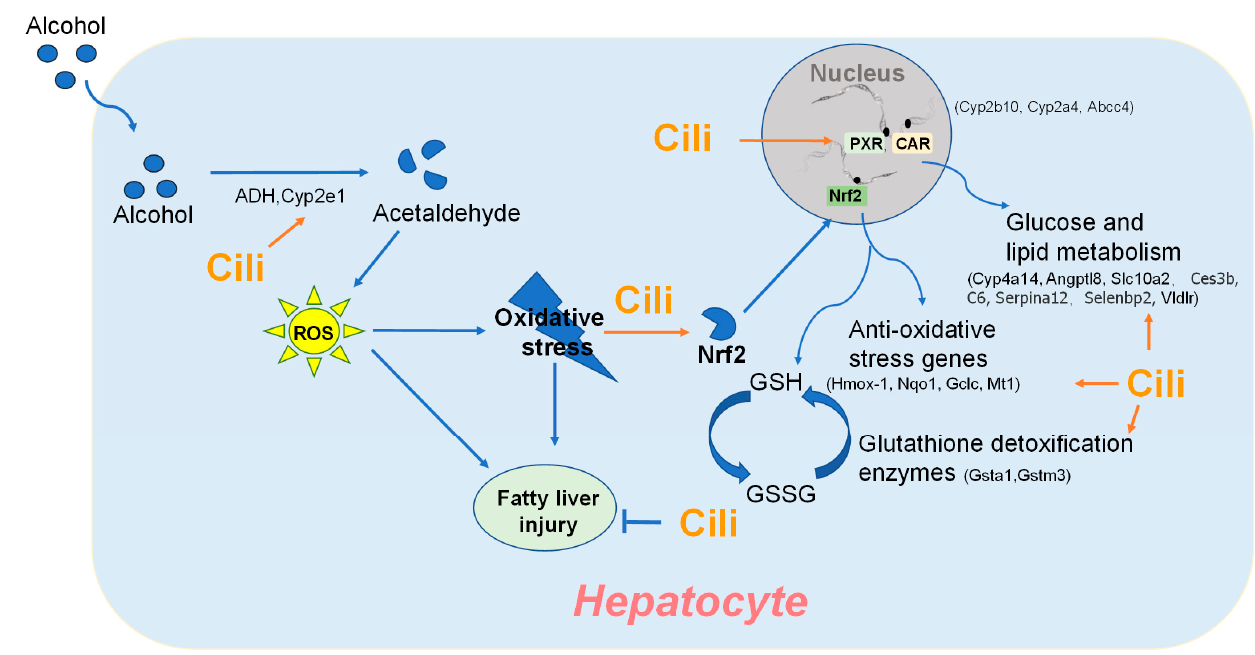
Figure 10. Proposed protective mechanism of Cili against alcoholic liver